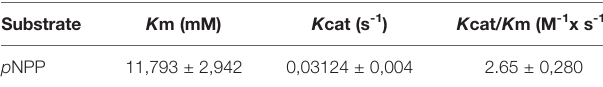
TABLE 1 | Kinetic parameters of rN15- Ld TyrPIP_22-His (values are means ± S.E.M.). Substrate K m (mM) K cat (s -1